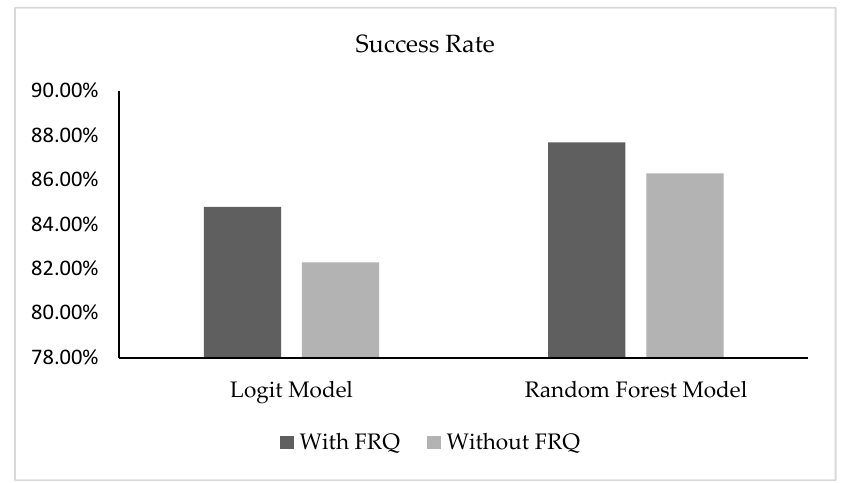
Figure 1. Logit and random forest comparison.